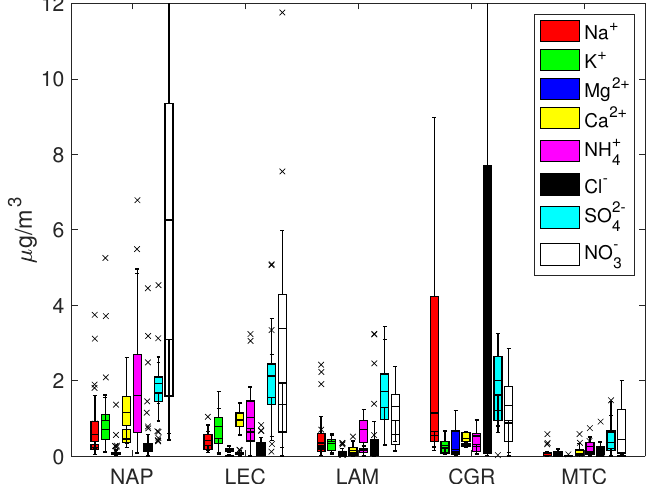
Figure 2. Box and whisker plots for PM 10 .